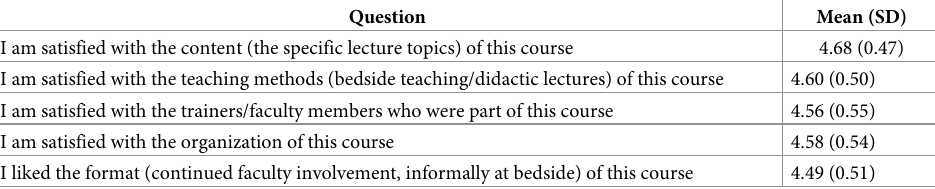
Table 4. Overall course satisfaction of participants � .